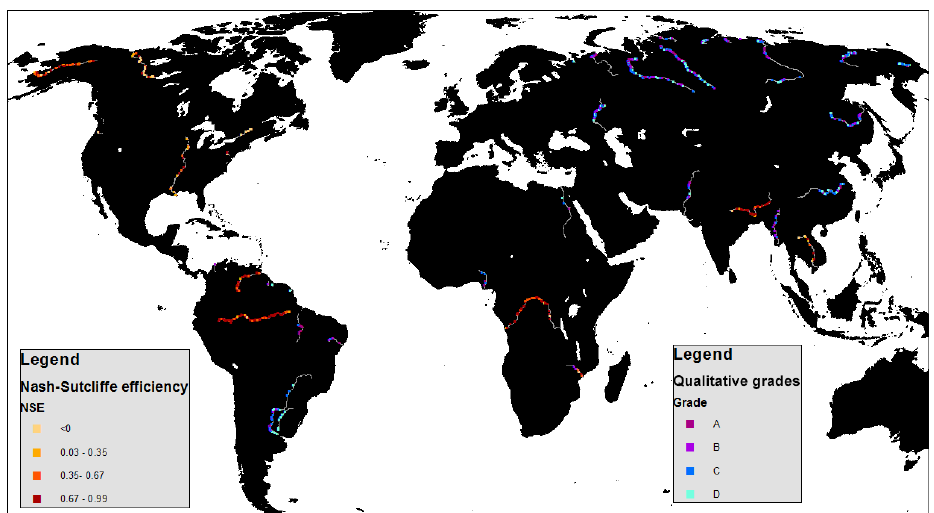
Figure 1. The GRRATS dataset and evaluation results. Maximum NSE (best fit) plotted in yellow to red (shown on all rivers with gage data) and qualitative grades plotted in teal to dark purple. In both cases, darker colors indicate better evaluation results. Each river is evaluated using only one of these methods.